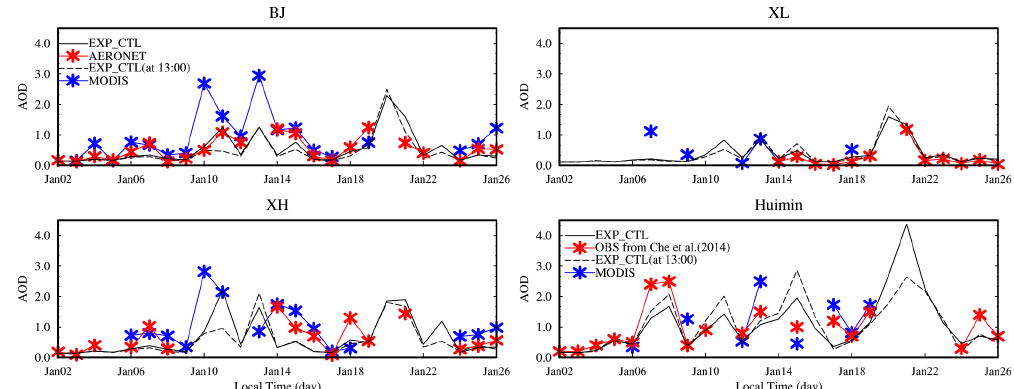
Figure 5. Time series of daily AOD at 550nm at BJ, XL, and XH from AERONET measurements and at Huimin site from Che et al. (2014), MODIS retrievals (at 13:00 LT), and the corresponding WRF-Chem simulation (EXP_CTL) for daily average (solid black line) and at 13:00 LT (dash black line) during 2–26 January